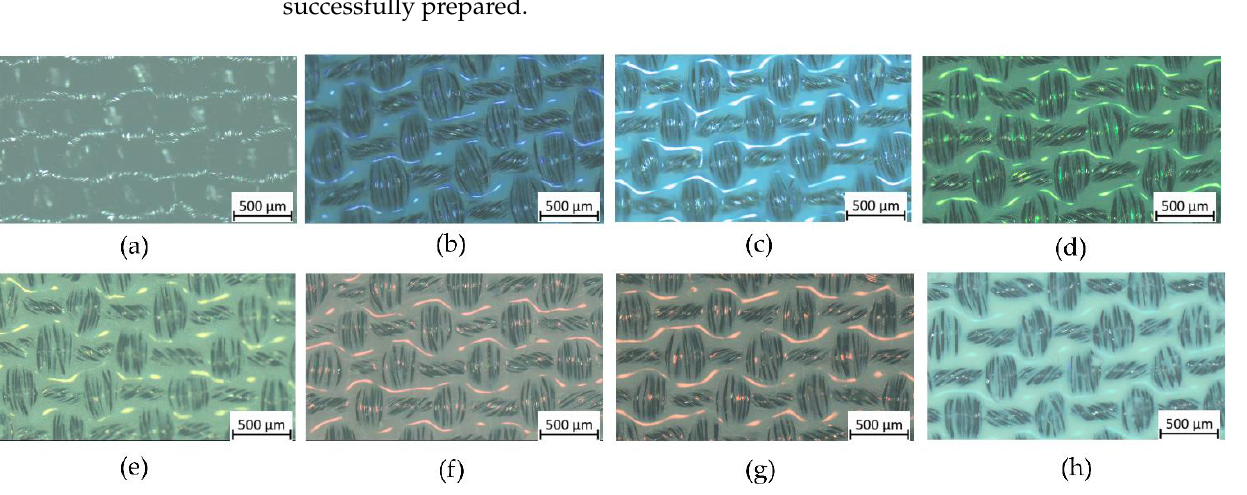
Figure 4. ( a – h ) Different structural colors on black silk taken by metallographic microscope. The diameters of SiO 2 @PDA microspheres are 198 nm, 234 nm, 271 nm, 290 nm, 330 nm, 360 nm, and 394 nm, respectively.